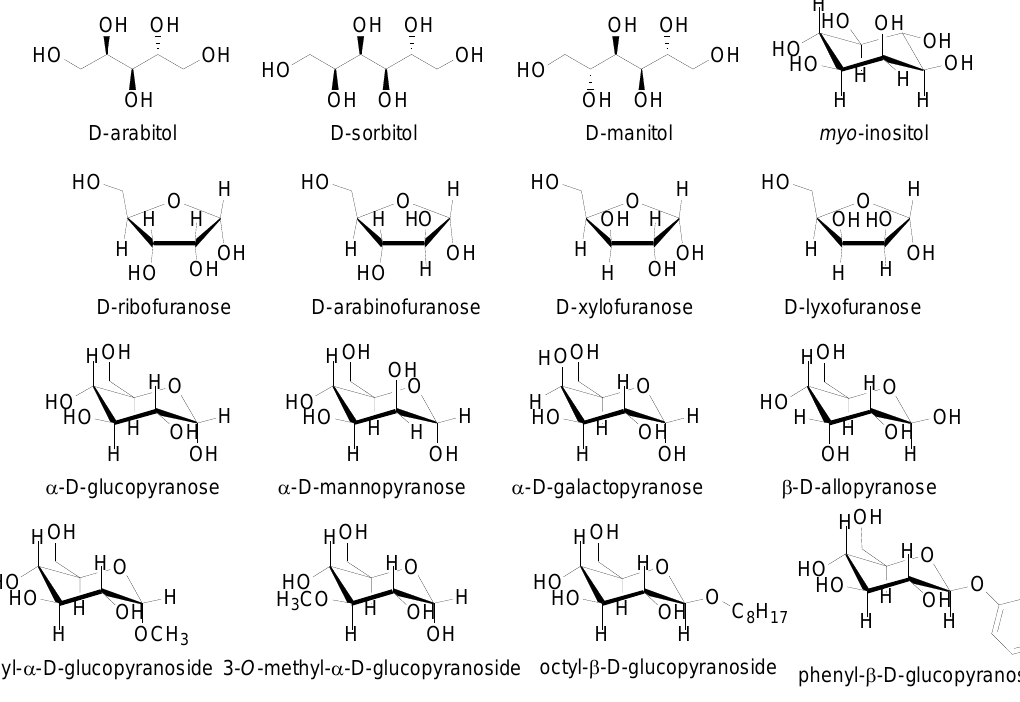
Figure 3. Structure of starting sugar alcohols, furanoses, pyranoses as well as gluco-, manno- and galactopyranoside derivatives used as potential